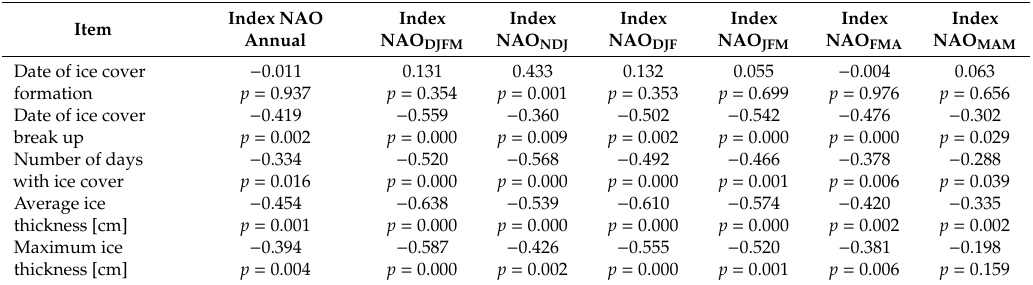
Table 1. Pearson’s correlation coe ffi cients between the water body ice cover data and the NAO indices for the Kozłowa G ó ra water body.